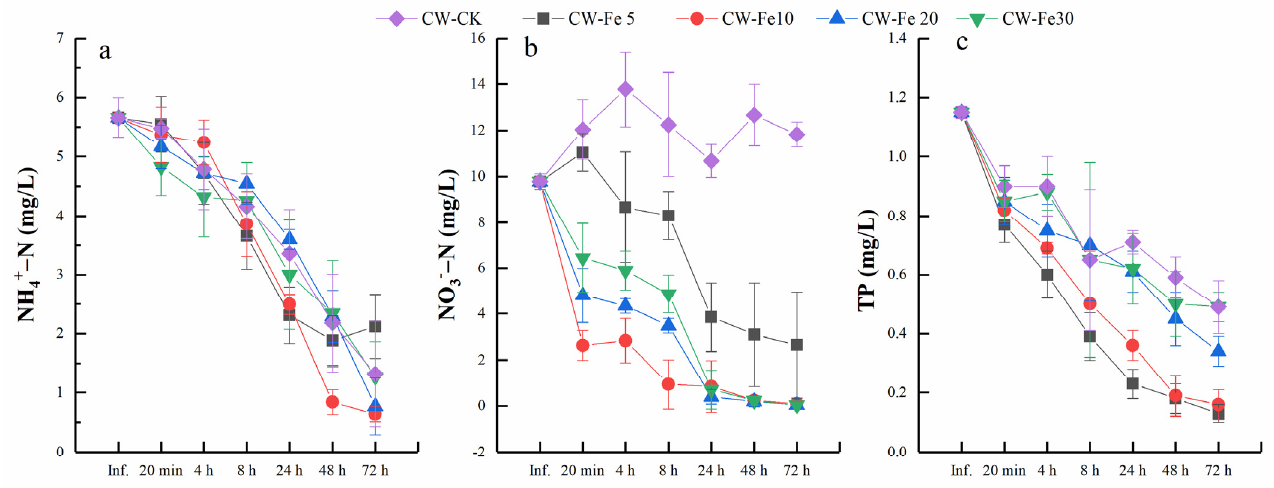
Figure 2. Changes of NH 4 + -N ( a ), NO 3 − -N ( b ), and TP ( c ) with HRT and influent Fe 2+ concentrations.